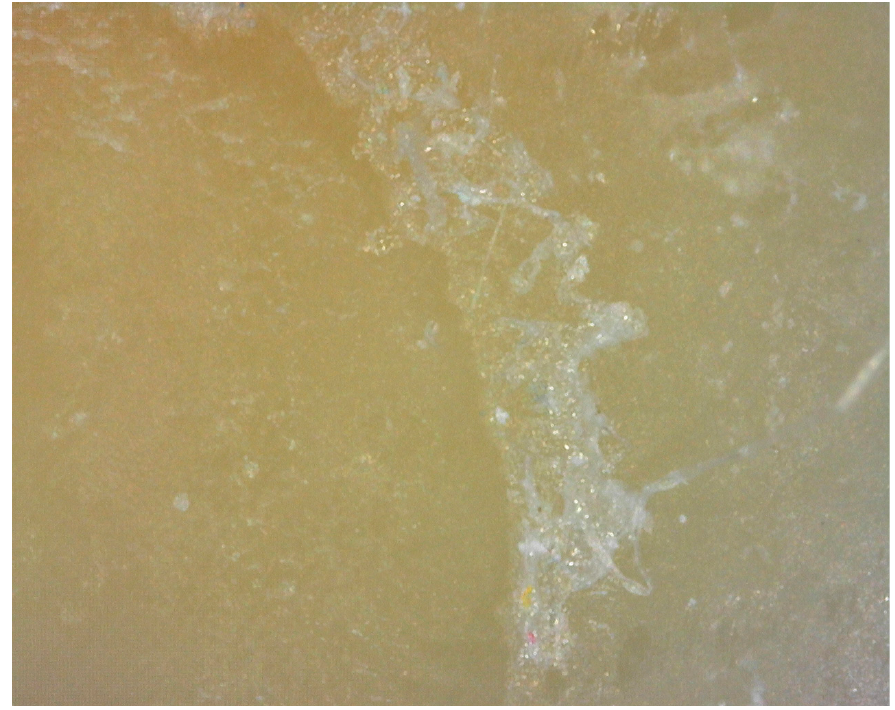
Figure 5. Adhesive fracture between the composite sample and dentin surface.